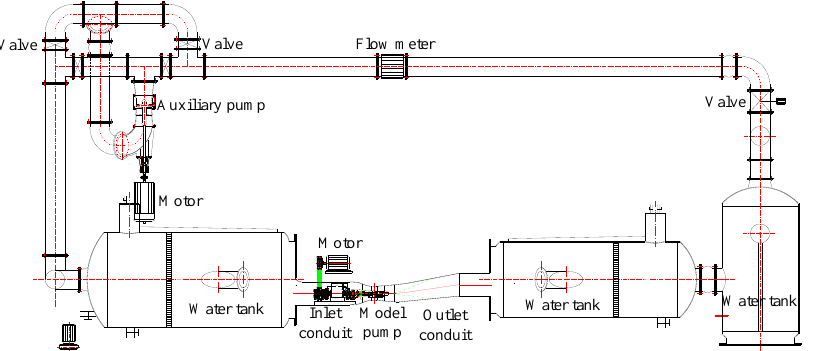
Figure 7. Schematic diagram of the flat closed circulation system of the test bench.